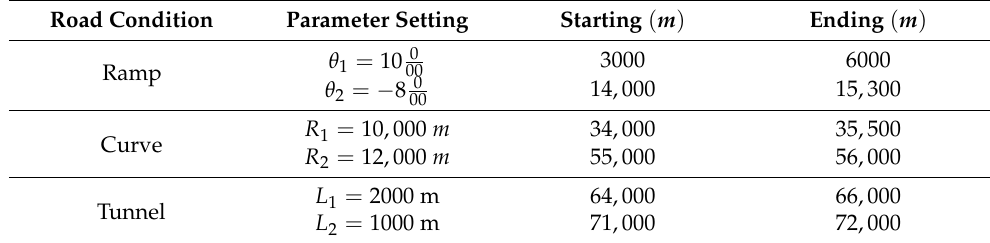
Table 1. Ramp, curve, and tunnel road parameters.